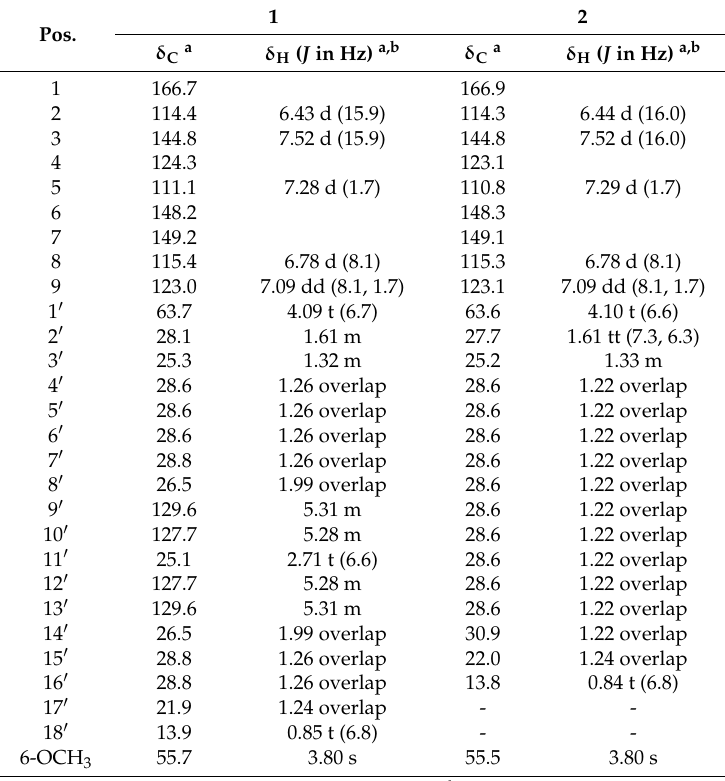
Table 2. NMR spectroscopic data (DMSO- d 6 , 600 and 150 MHz for 1 H and 13 C, respectively) of compounds 1 and 2 acquired at 300